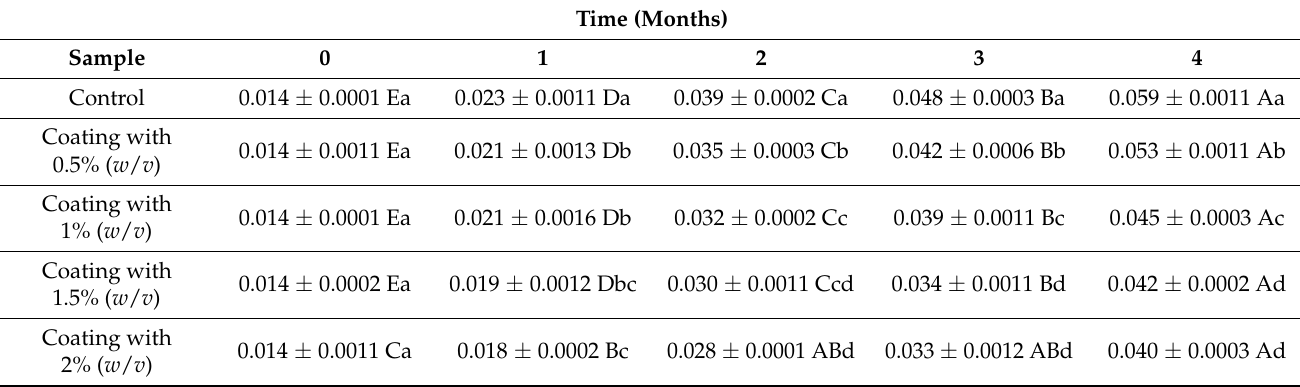
Table 3. Changes in the peroxide value of uncoated (control) and coated almonds during 4 months storage in mill equivalents of oxygen per kilogram of